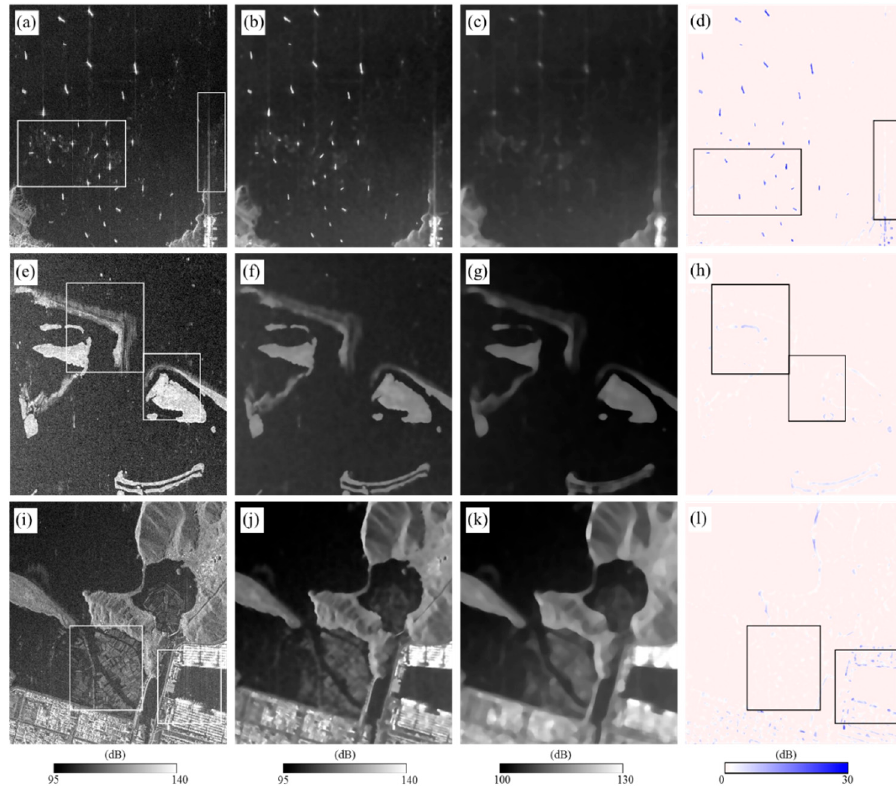
Figure 3. Procedure for the generation of a differential image, one of the input layers of artificial neural network (ANN): ( a , e , i ) the intensity images, ( b , f , j ) the NL-means filtered images, ( c , g , k ) the median filtered images and ( d , h , l ) differential images in the boxes A, C and D (see Figure 1).